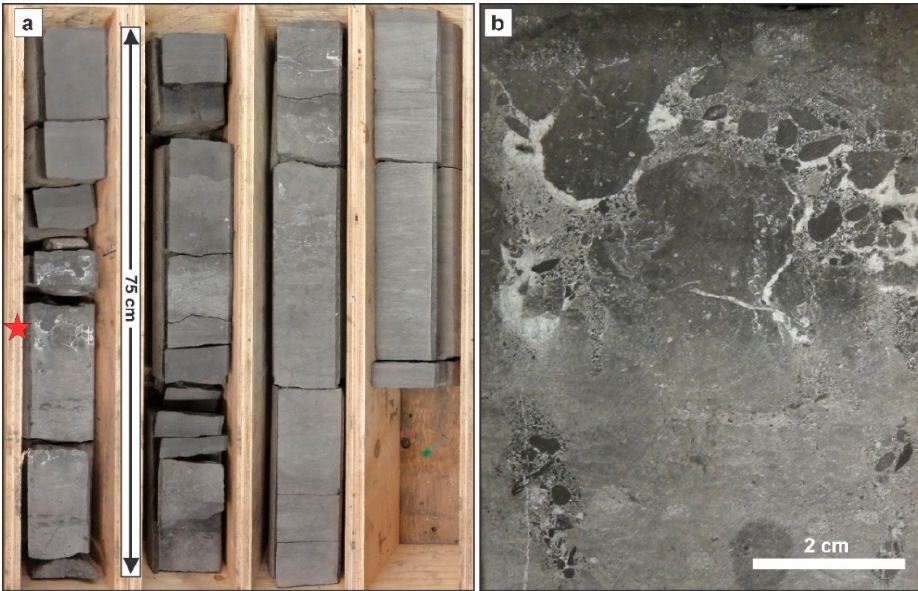
Figure 5. ( a ) Photographs of core box of the interval between 2422.46 and 2425.46 m of well 200 / a-063-A 093-P-09 / 00, which contains a 15 cm intraclastic phosphorite bed, indicated by a red star, and corresponding to sample MH6. ( b ) Close up view of the phosphorite bed, showing the dark phosphatic intraclasts containing light skeletal carbonate fragments only partially phosphatized, and siliciclastic grains, embedded in a silt-sized phosphatic coated grains framework and cemented by calcite.